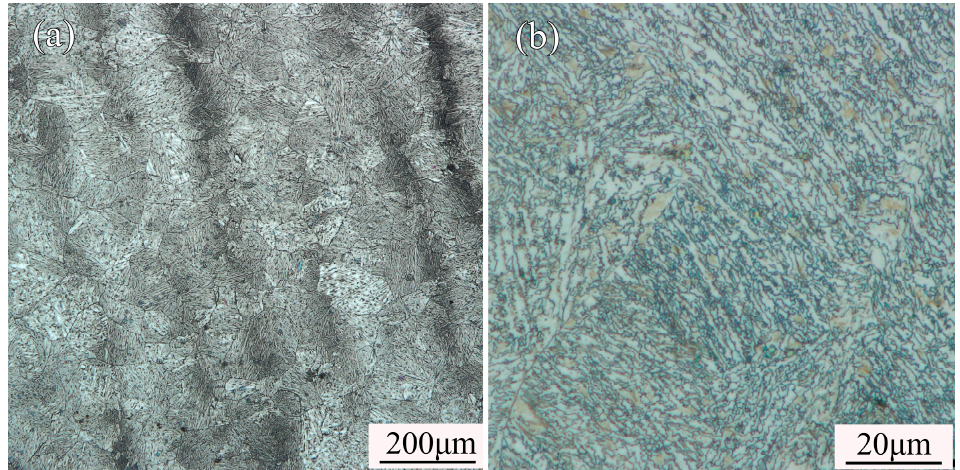
Figure 1. Microstructure of as-received 300M steel photographed on optical microscope showing: ( a ) the initial grains were equiaxed and ( b ) the initial phase was spheroidized